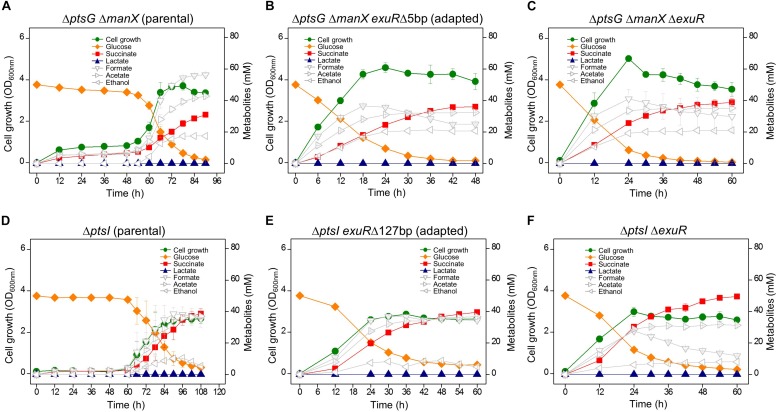
Anaerobic cell growth and fermentation profiles. (A) K-12 BW25113 ΔptsG ΔmanX (parental strain), (B) ΔptsG ΔmanX exuRΔ5bp (adapted progeny strain), (C) ΔptsG ΔmanX ΔexuR, (D) ΔptsI (parental strain), (E) ΔptsI exuRΔ127bp (adapted progeny strain), and (F) ΔptsI ΔexuR.